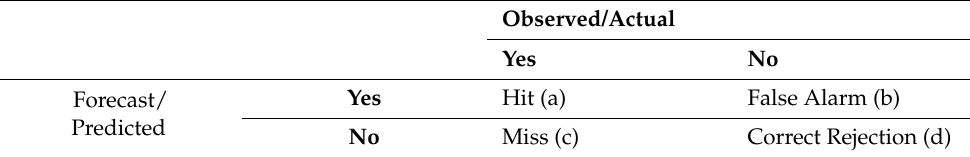
Table 3. Contingency